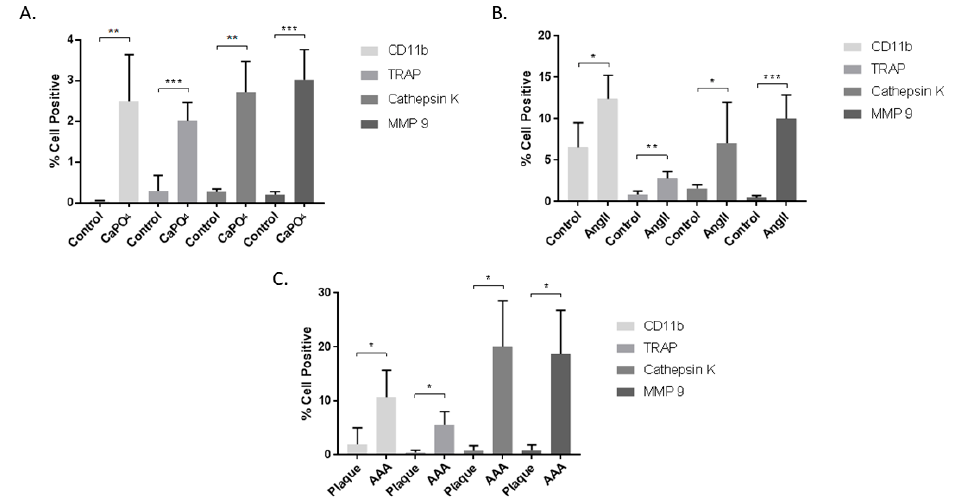
Figure 4. Cells from mouse CaPO 4 ( A ), mouse AngII ( B ), and human ( C ) aneurysms exhibit increased expression of the myeloid marker, CD11b, and the osteoclastogenic markers TRAP, cathepsin K, and MMP-9. Tissues from CaPO 4 mice ( n = 5), AngII mice ( n = 6) and PBS-only controls ( n = 3), human AAA ( n = 4), and human carotid plaques ( n = 3) were enzymatically digested and processed to obtain single cell suspensions for flow cytometric analysis, as described in the Methods section. Data are expressed as mean ± SEM. * p < 0.05, ** p < 0.01, *** p < 0.001. AAA, abdominal aortic aneurysm.